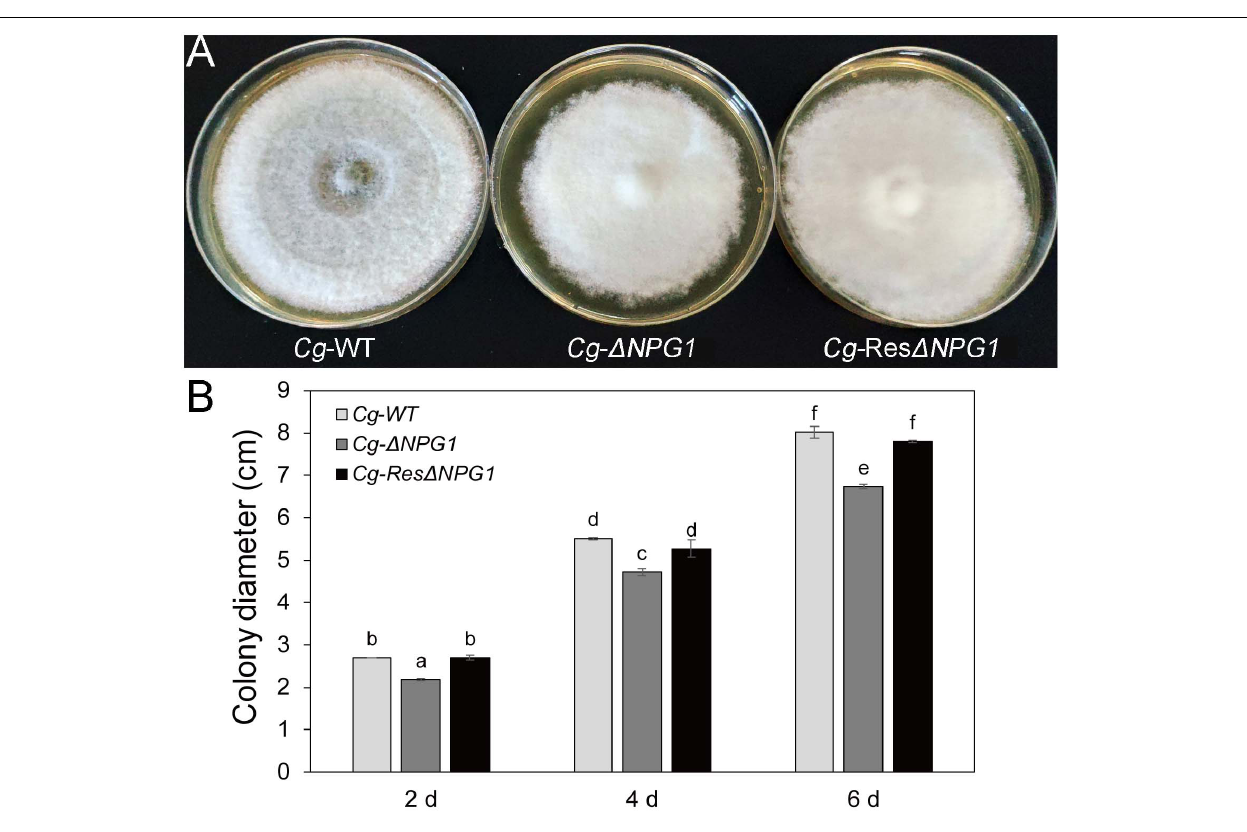
FIGURE 3 | Growth rate assays of CgNPG1 deletion and complementation mutants of C. gloeosporioides Hb. (A) Colonial morphology of wild type strain (Cg-WT), the CgNPG1 deletion mutant (Cg- (cid:49) NPG1), and complementation mutant (Cg-Res (cid:49) NPG1) after culture for 8 day on potato dextrose agar. (B) Colony diameters at 2, 4, and 6 day post-inoculation. Error bars indicated standard deviation, and columns with different letters indicate significant difference ( P < 0.05).